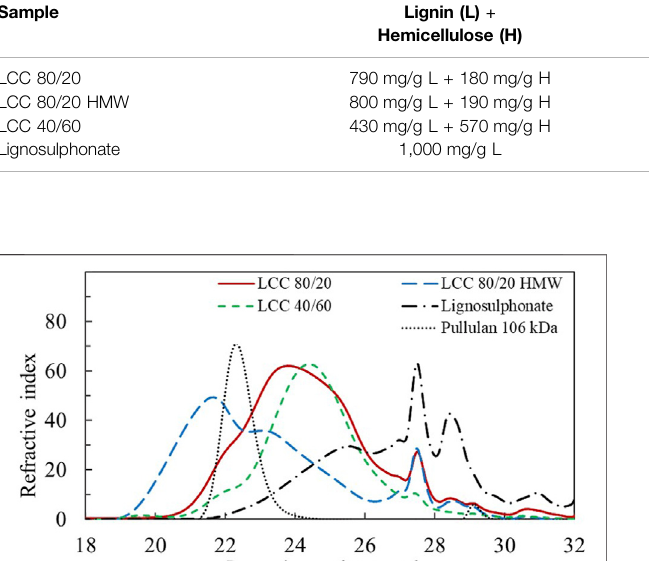
TABLE 1 | Lignin/hemicellulose ratio, charge density at pH 6 and apparent molar mass for LCC 80/20, LCC 80/20 HMW, LCC 40/60 and lignosulphonate. Sample